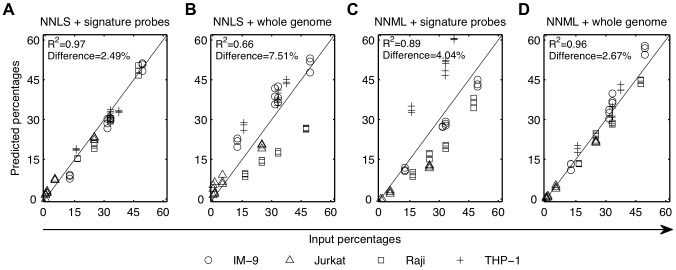
NNML recovers known compositions of immune cell line mixtures.Microarray data of IM-9 (○), Jurkat (▵), Raji (□), THP-1 (+), and the mixtures of these four cell lines in known proportions were obtained from Abbas et al. (2009). Proportions of each cell line were predicted using (A) NNLS with cell line signature probes (reproduced from Abbas et al. (2009)), (B) NNLS without cell line signature probe, (C) NNML with cell line signature probes, and (D) NNLS without cell line signature probes. Model predictions were compared with the input proportions used to create the mixtures. Cell line signature probes were obtained from Abbas et al. (2009).